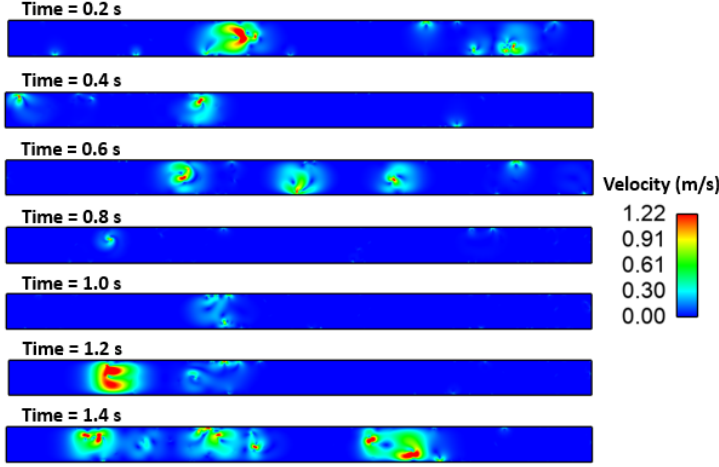
Figure 13. Velocity field of inclusion and molten steel (S: 70 PPM).